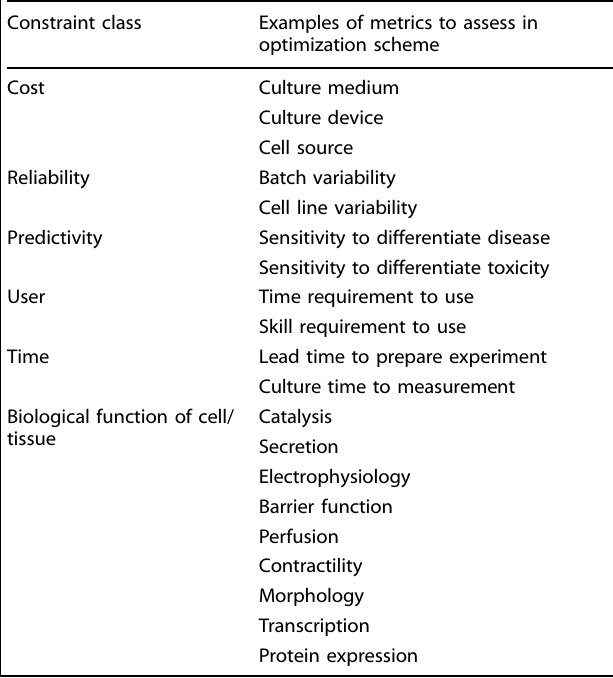
Table 8. Constraints in experimental design or system optimization in cell culture and tissue